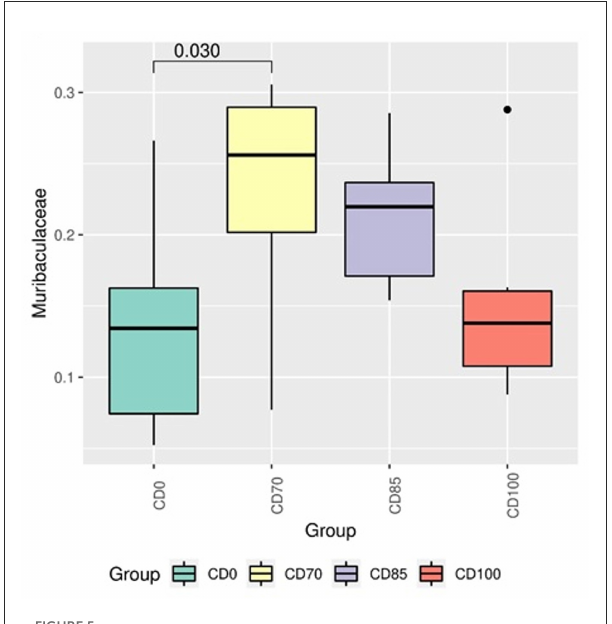
FIGURE6 Differential abundance analysis of taxon of the Prevotella genus in finisher pigs fed 1 of 4 dietary treatments: a control diet containing isolated phytase and xylanase valued at 40 kcal of ME/kg (CD0), CD0 + β -mannanase (0.3 g/kg valued at 30 kcal of ME/kg) (CD70), CD0 + β -mannanase (0.3 g/kg valued at 45 kcal of ME/kg) (CD85), and CD0 + β -mannanase (0.3 g/kg valued at 60 kcal of ME/kg) (CD100). Data are averages of 6 pigs per dietary treatment. Means differed by Wilcoxon test ( P <